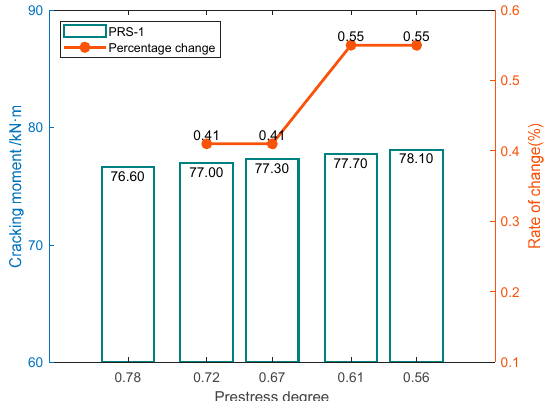
Figure 13. Effect of non-prestressed reinforcement on cracking moment.